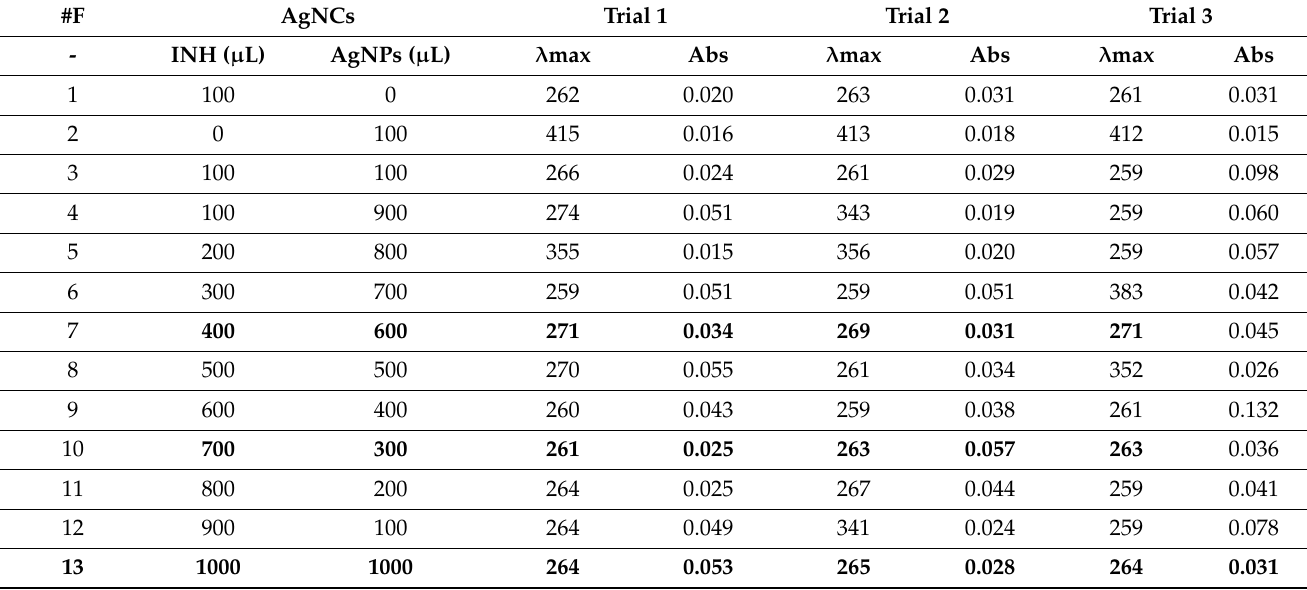
Table 4. λ max and absorbance values of AgNCs at various compositions ( v/v